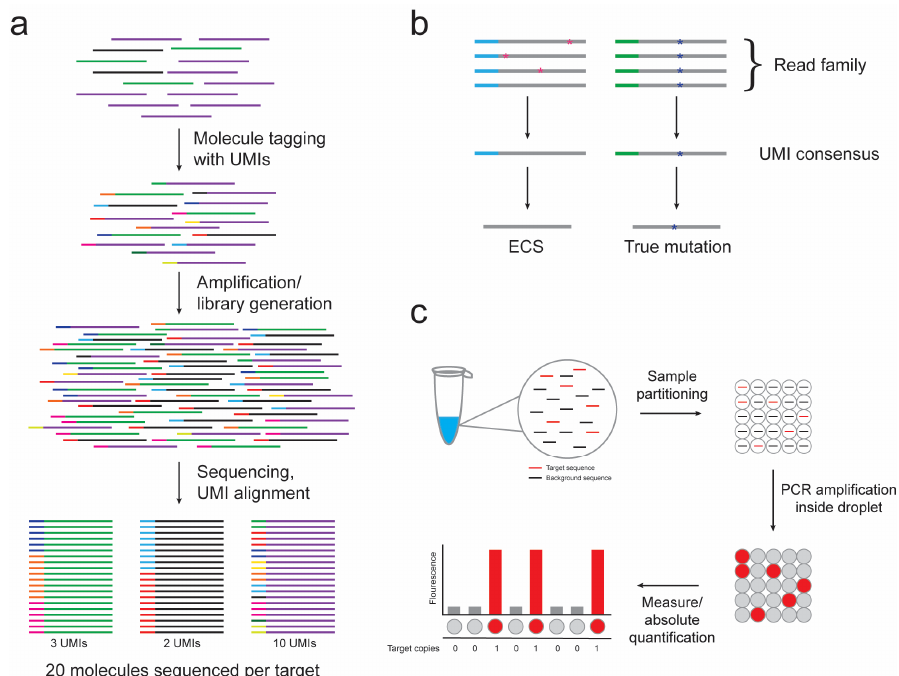
Figure 1. The use of unique molecular indexes (UMIs) in next-generation sequencing (NGS) libraries and droplet digital PCR (ddPCR) provide technical advances for measurable residual disease (MRD) detection. ( a ) Molecules consisting of three different nucleic acid targets (purple, green, and black lines) are individually tagged with UMIs. The UMI tags are maintained throughout amplification and library generation and are used to count the number of original target molecules present in the sample despite PCR amplification bias. ( b ) Alignment of read families (grey line) sorted by UMIs (blue or green line) allows for the discrimination of true mutations (blue asterisk) from sporadic errors introduced during PCR or sequencing procedures (pink asterisk). ( c ) A single PCR reaction is partitioned by ddPCR into thousands to millions of water–oil droplets for which no more than a single target sequence (red line) is present per droplet. PCR amplification is performed within the droplets and the fluorescent signal is measured as either positive or negative, allowing for absolute target copy number quantification.